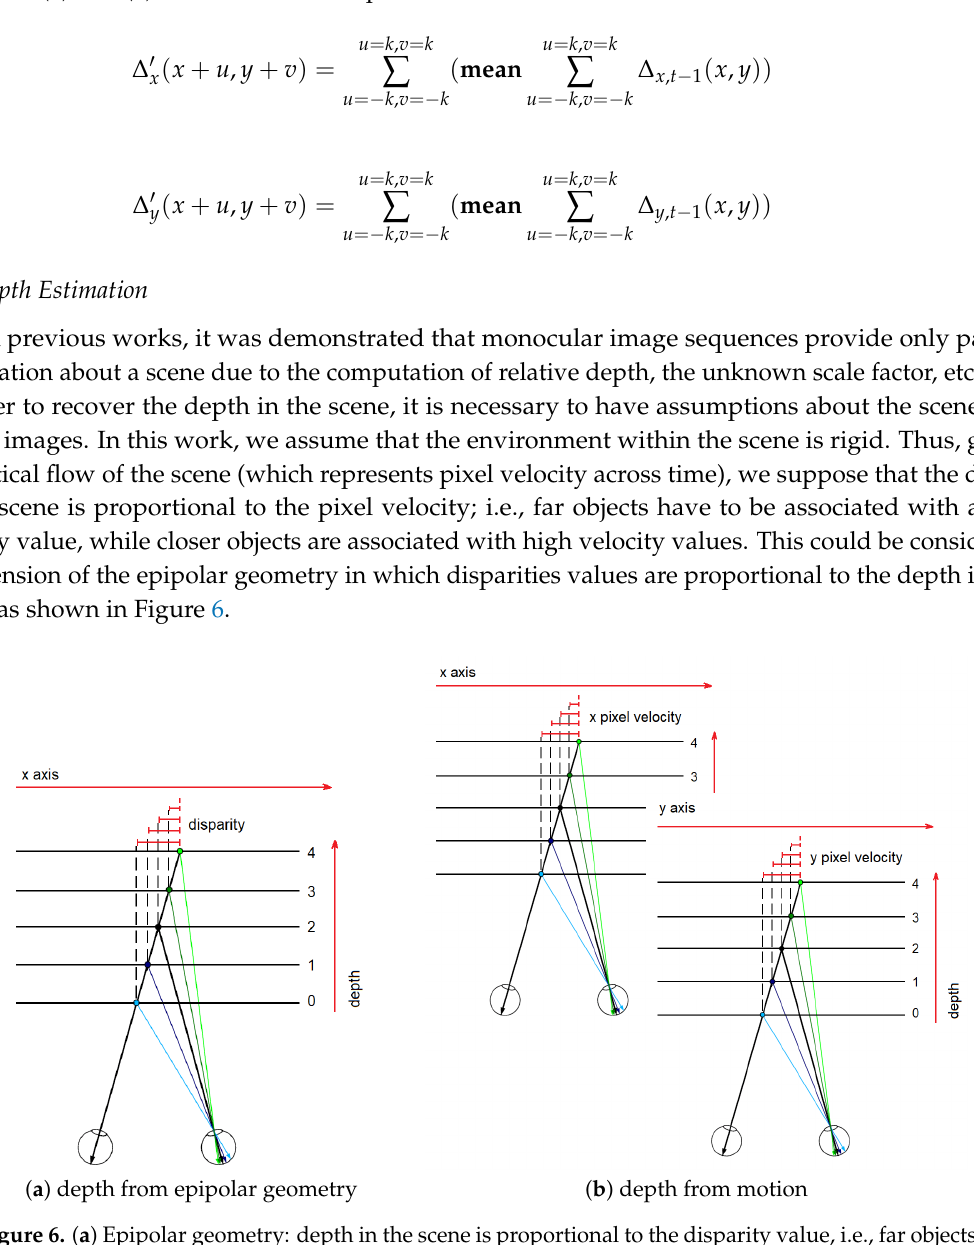
Figure 6. ( a ) Epipolar geometry: depth in the scene is proportional to the disparity value, i.e., far objects have low disparity values, while closer objects are associated with high disparity values. To compute the disparity map (disparities for all pixels in the image) a stereo pair (two images with epipolar geometry) are needed. ( b ) Single moving camera: in this work we suppose that depth in the scene is proportional to the pixel velocity across the time. To compute the pixel velocity, optical flow across two consecutive frames has to be